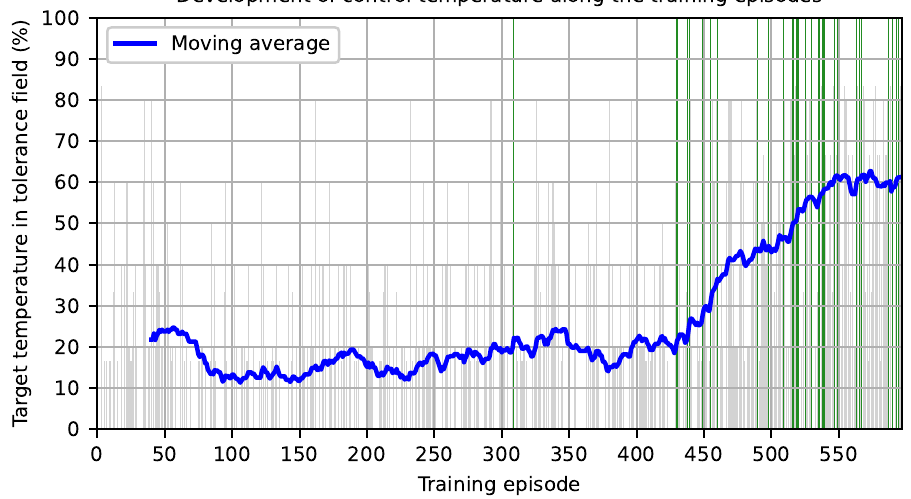
Figure 8. The percentage of next state temperatures within the thermal tolerance window in- creases